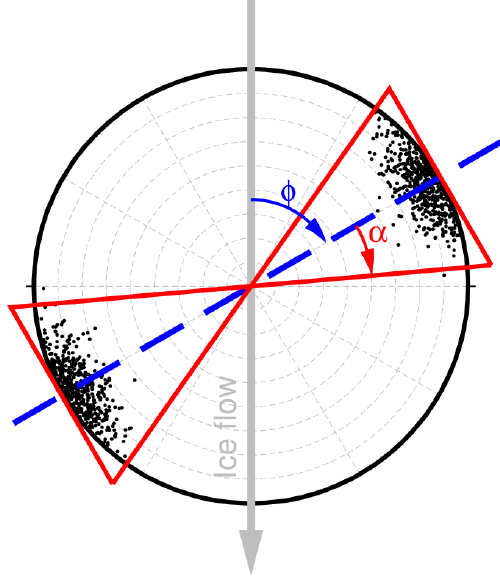
Figure 6. Upper-hemisphere stereographic projection c -axis orien- tations of an example horizontal-cluster CPO model with illustra- tion of model parameters: cluster orientation ϕ and opening angle α